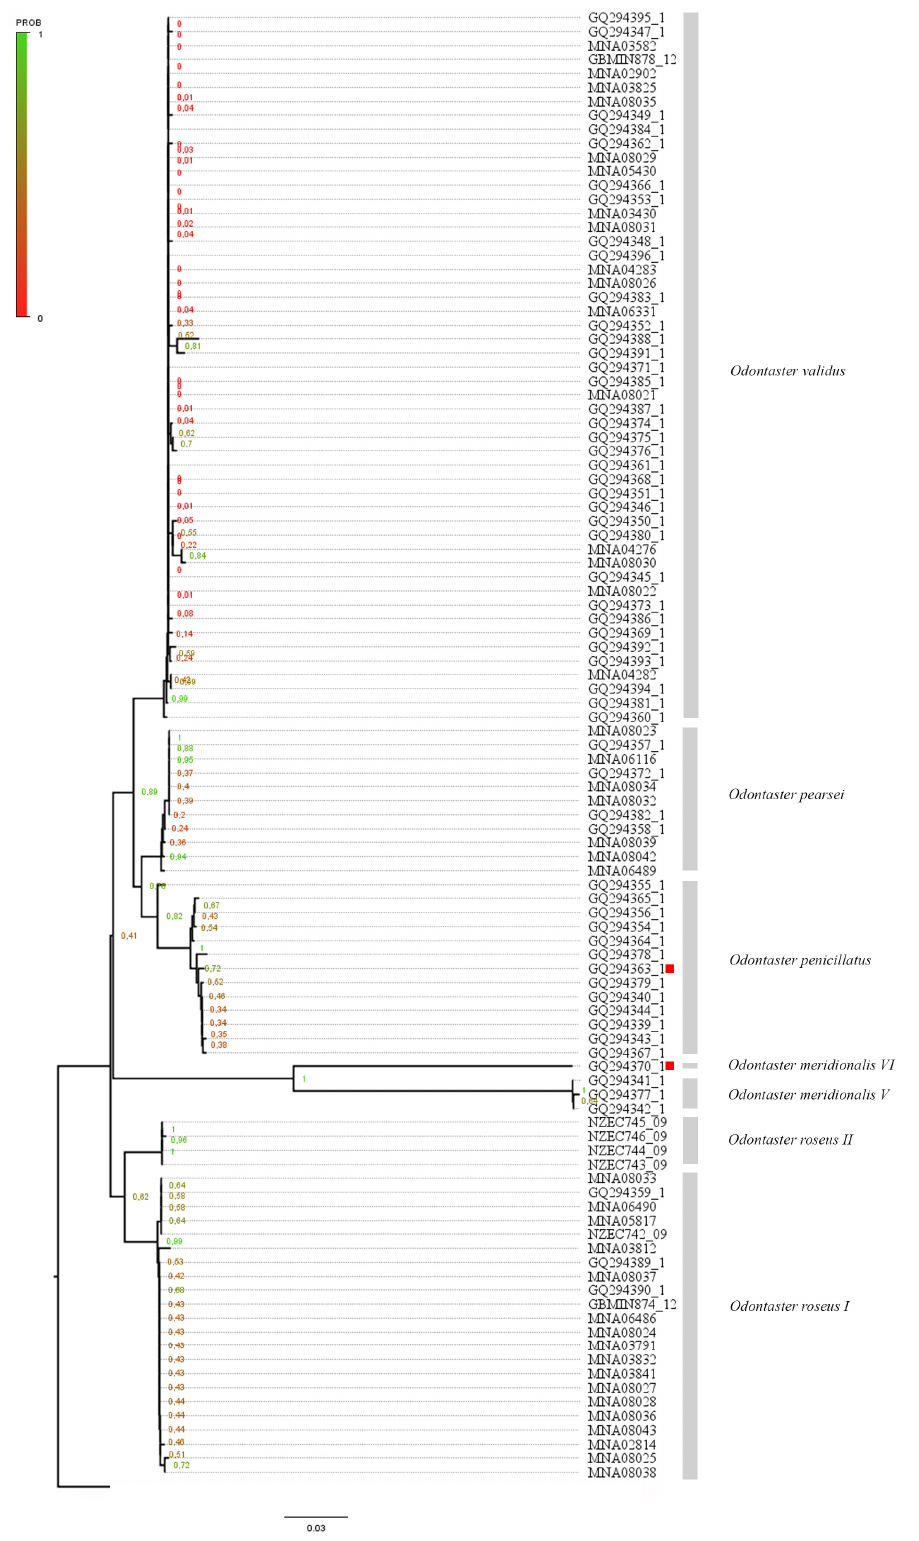
Figure 3. Maximum likelihood (ML) tree topology of the 105 COI sequences from the Odontaster genus. Posterior probability node values is shown on the tree with corresponding legend. Species names are reported near corresponding clades. Sequences GQ294370.1 and GQ294363.1 (from Janosik et al. [35]) are highlighted in red.